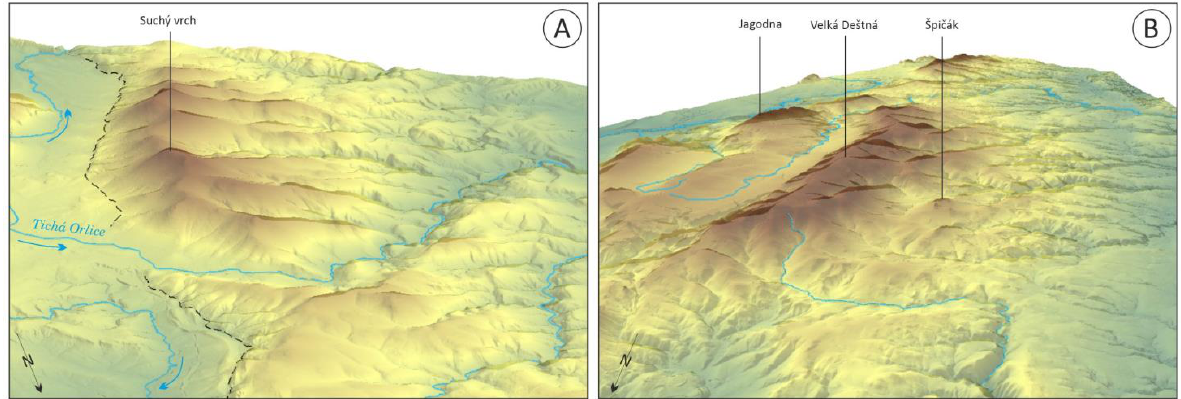
Figure 9. Two representative 3D visualizations, meant to enhance views available from the ground level. Image ( A ) corresponds to the ground view from Mt. Jedlnik (Figure 6G) and shows the entire Suchý vrch massif, highlighting its asymmetry, as well as the water gap of Tichá Orlice river, not visible from the viewing point. Image ( B ) corresponds to the view from Dobrošov (Figure 6B) and allows to see the downfaulted blocks located beyond the main ridge of the Orlick é hory and the large extent of the